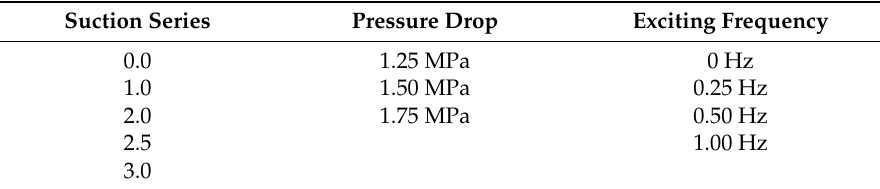
Table 1. Experimental condition.